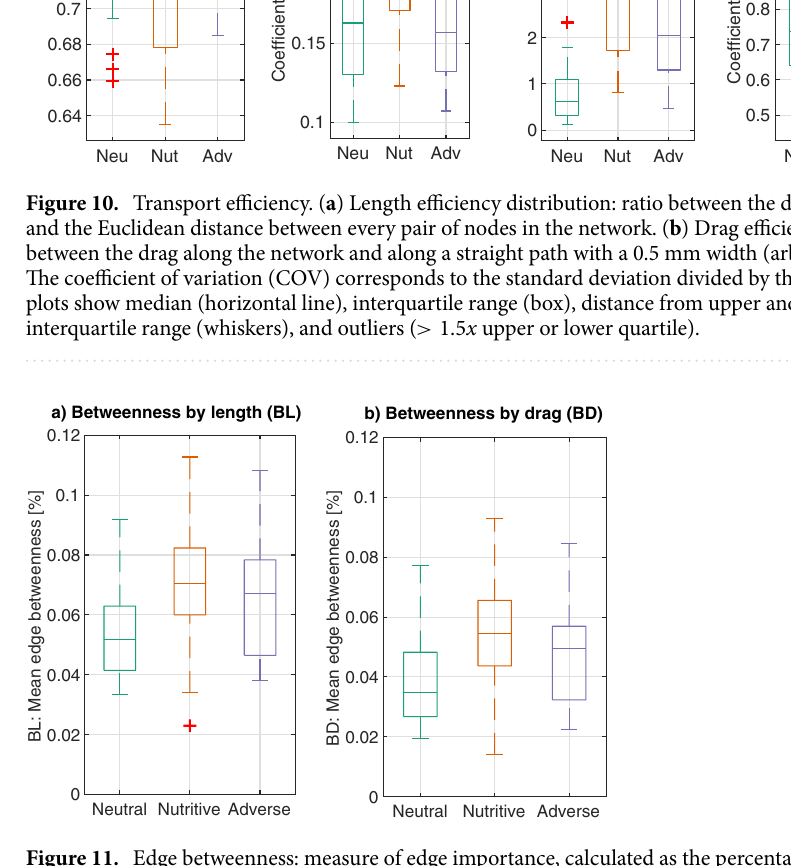
Figure 11. Edge betweenness: measure of edge importance, calculated as the percentage of shortest paths between nodes that pass through each edge. ( a ) Mean betweenness considering that the graph is weighted by the edge length (BL). ( b ) Mean betweenness considering that the graph is weighted by the edge drag (BD). Box plots show median (horizontal line), interquartile range (box), distance from upper and lower quartiles times 1.5 interquartile range (whiskers), and outliers ( > 1.5 x upper or lower